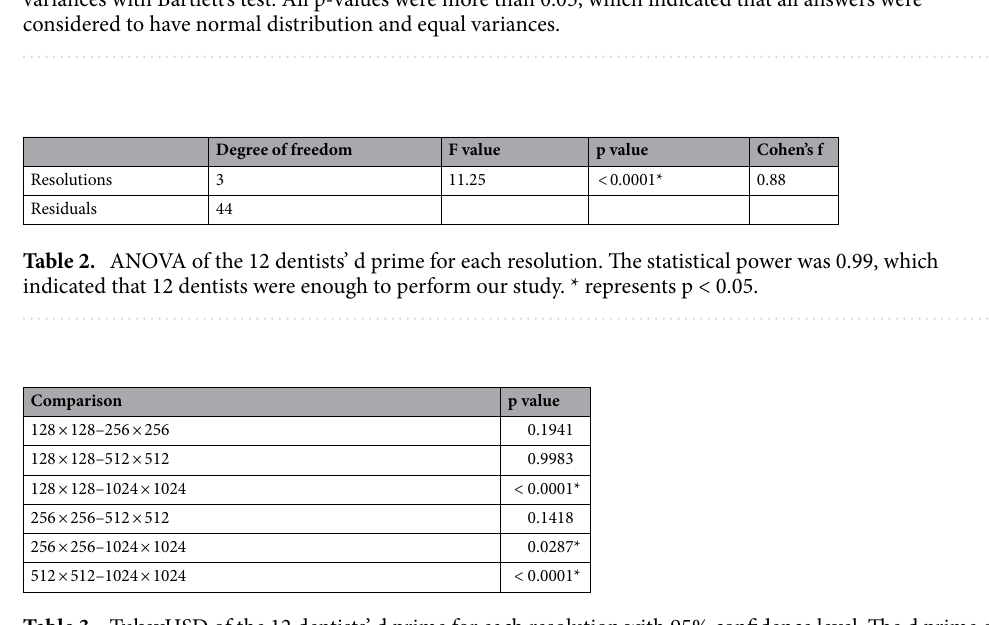
Table 3. TukeyHSD of the 12 dentists’ d prime for each resolution with 95% confidence level. The d prime of 1024 × 1024 resolution was significantly higher than that of 128 × 128, 256 × 256, and 512 × 512 resolutions. * represents p <